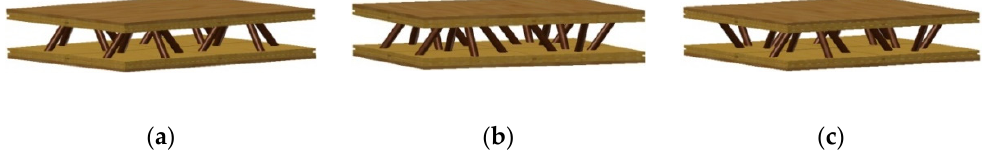
Figure 5. Lattice sandwich structure with reinforced veneer of type RI, RII, and RIII. ( a ) RI type specimen. ( b ) RII type specimen. ( c ) RIII type specimen.